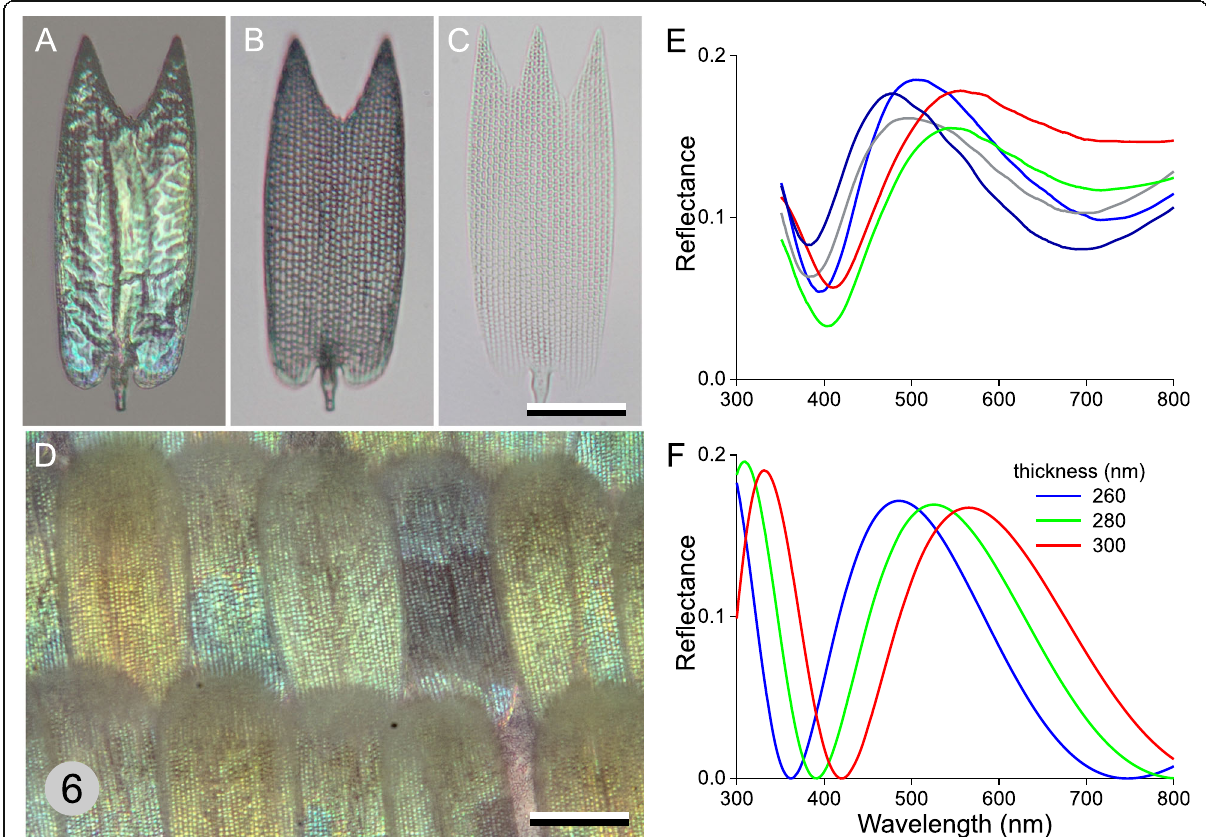
Fig. 5 Unpigmented ventral wing scales. a Epi-illumination image of the adwing side of an isolated ventral hindwing scale on an object slide. b The same scale in transmitted light. c Another ventral hindwing scale in oil immersion in transmitted light. d Lattice with varying colored scales on the ventral hindwing (Fig. 1b, #6). Scale bars: a - d 50 μ m. e Reflectance spectra of a number of adjacent ventral hindwing scales. f Reflectance spectra of chitinous thin films with thicknesses of 260, 280, and 300